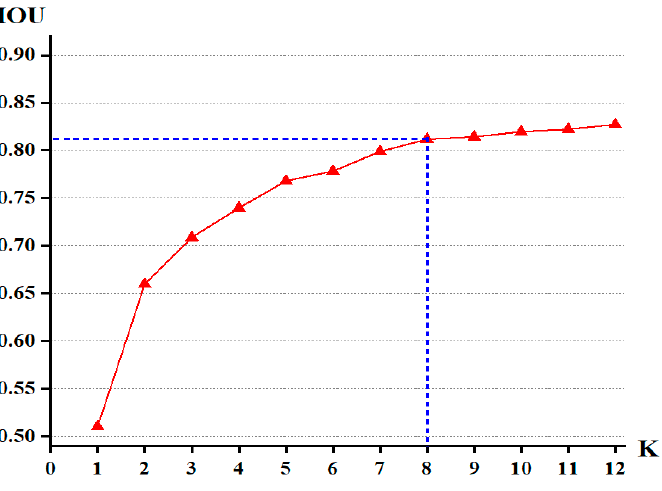
Figure 3. Structure of the improved network model.